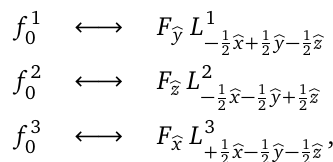
Figure 4: Operators creating planons (as dipoles of f i excitations) that commute with the edge terms. They have non-trivial mutual commutation